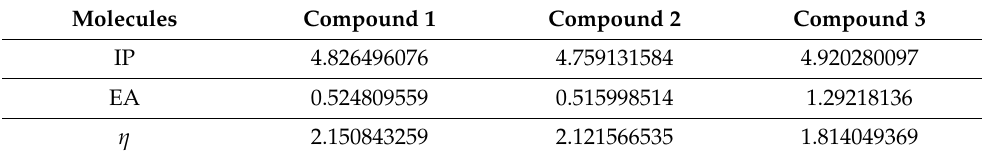
Table 3. The ionization potential IP (eV), electron affinities EA (eV) and absolute hardness η